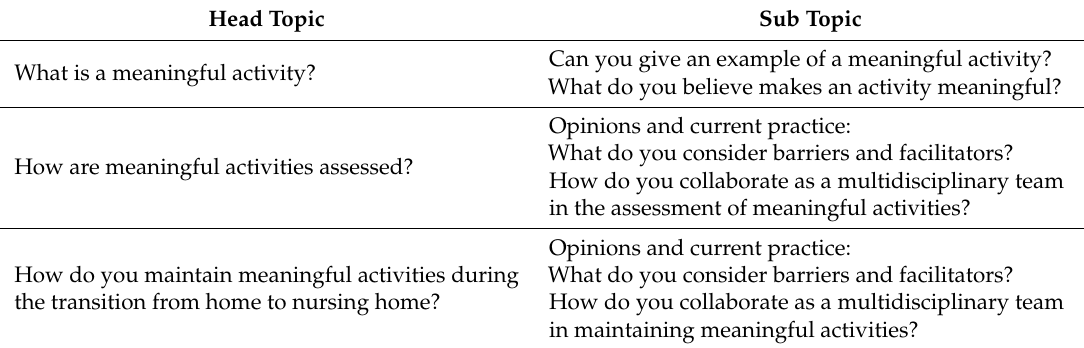
Table 1. Focusing exercise and main